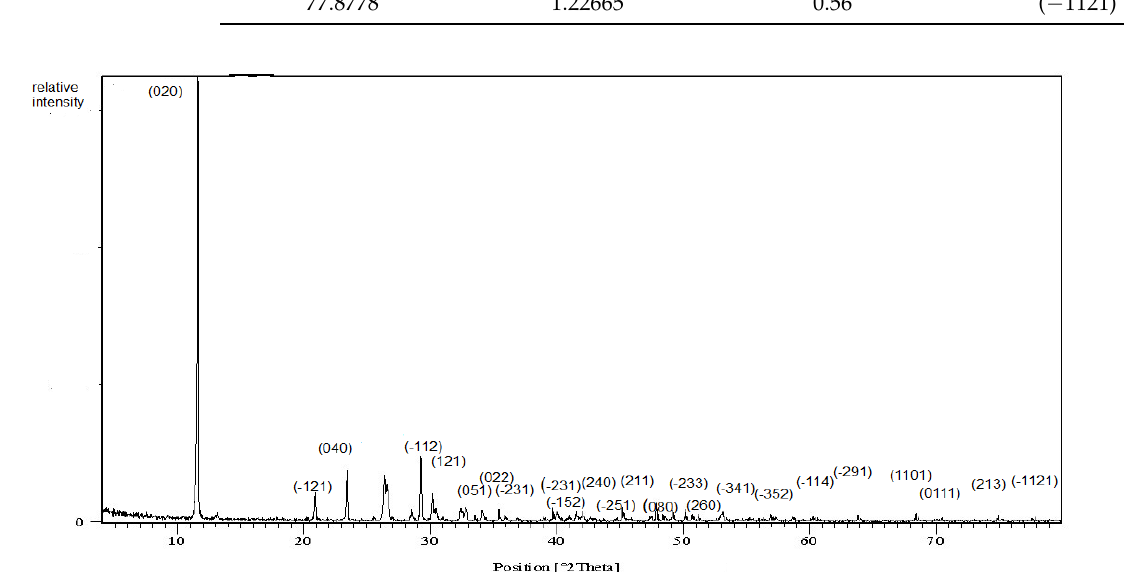
Figure 1. X-ray diffraction chart of the brushite. Table 3. Values of d-spacing, 2 theta, relative intensity and Miller indices (hkl) of the sample as extracted from the X-ray data analysis.